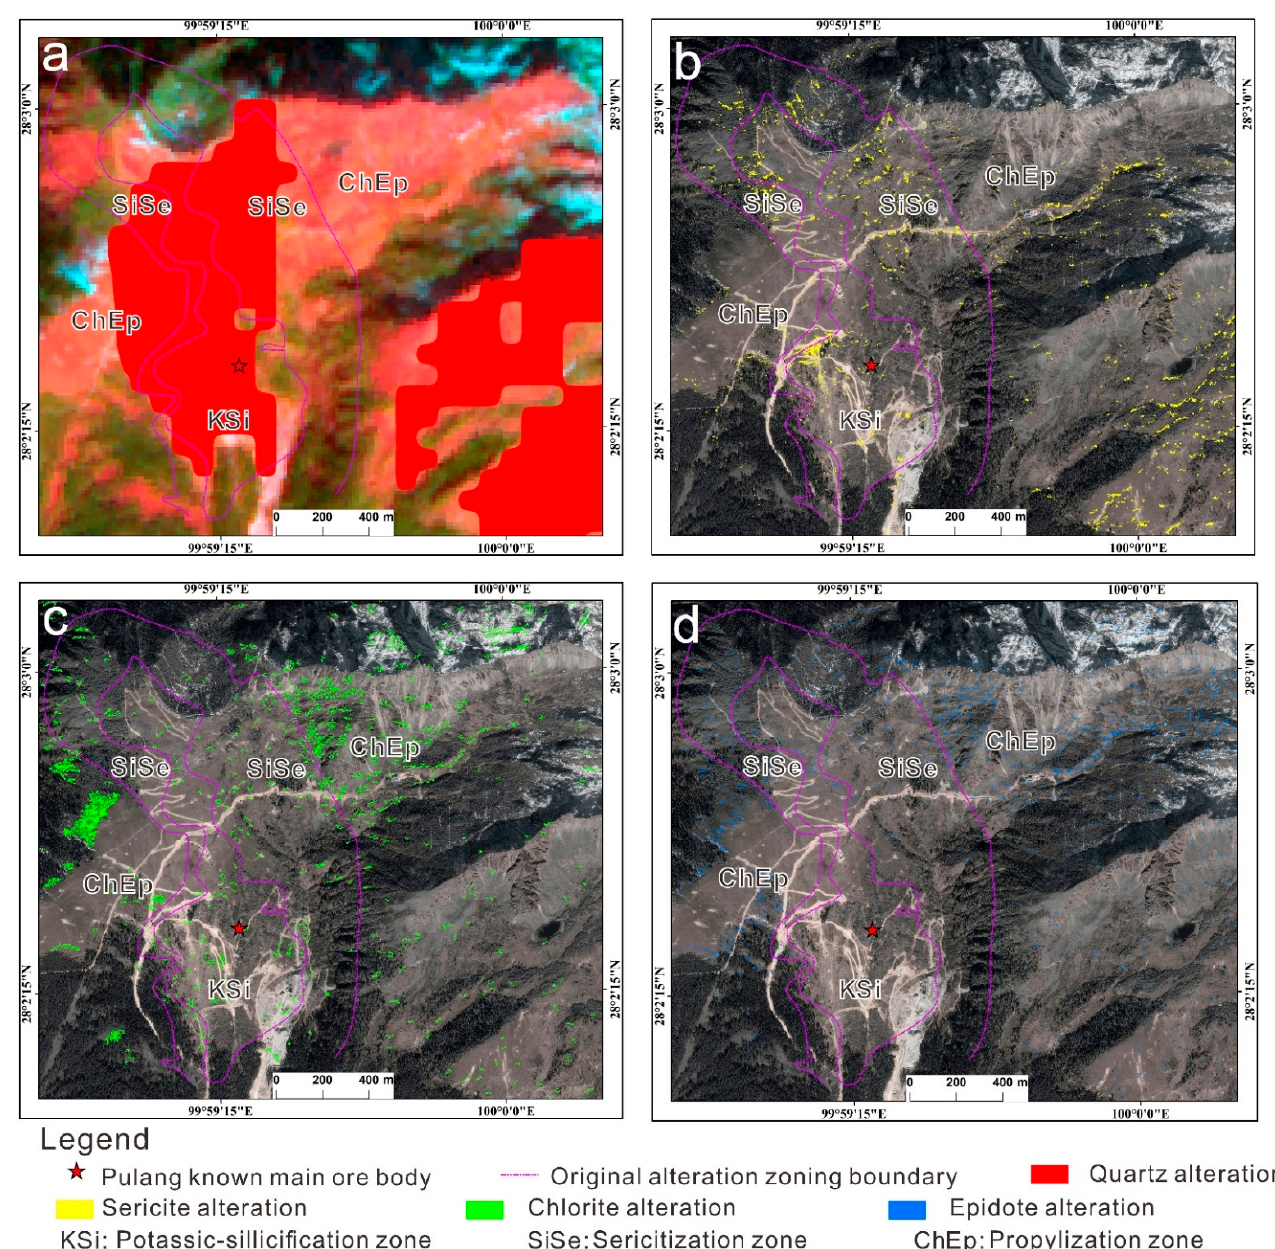
Figure 5. Extraction results of alteration minerals with ASTER and WV-3 data. ( a ) Quartz alteration; ( b ) sericite alteration; ( c ) chlorite alteration; ( d ) epidote alteration; the background of a is Band 6(R) 3(G) 2(B) composite image of ASTER data; the background of ( b – d ) is Band 5(R) 3(G) 2(B) composite image of WorldView-3 data.